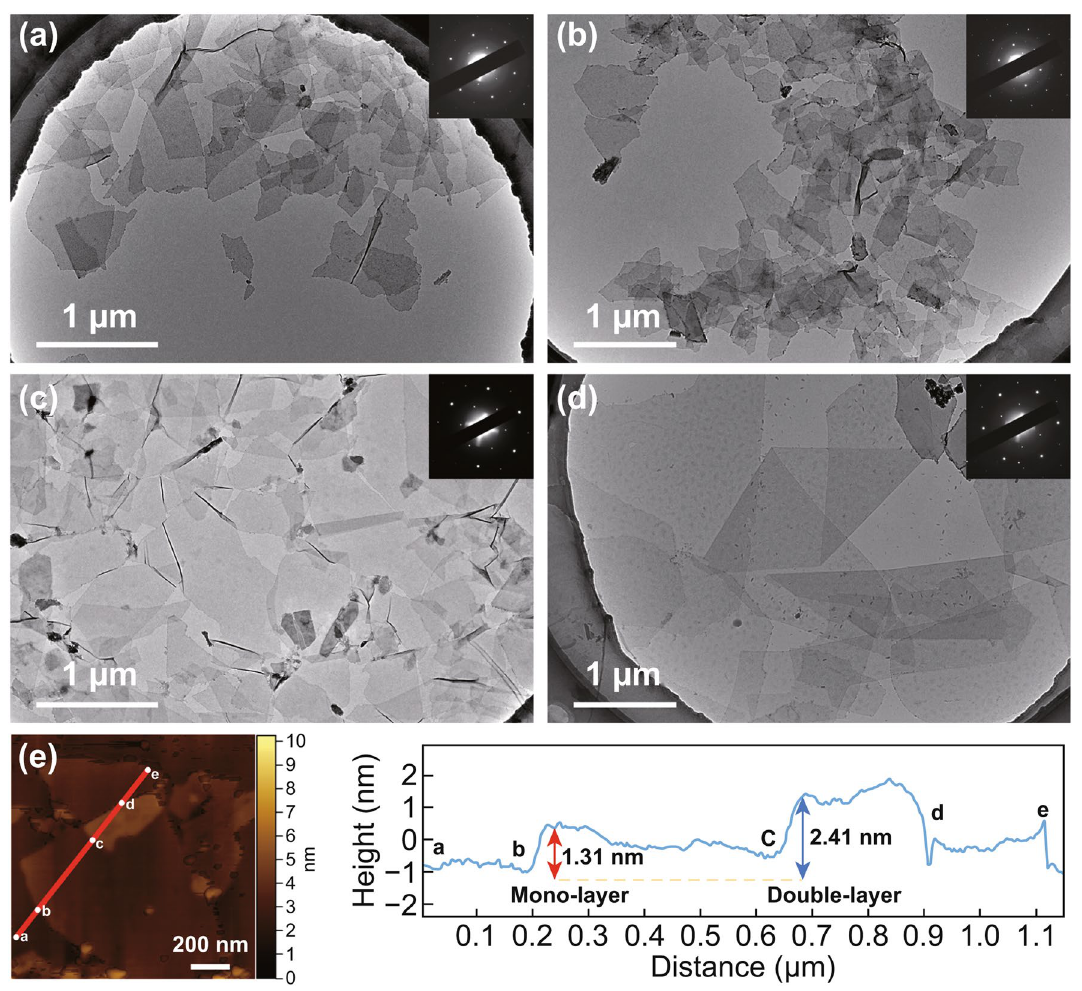
Fig. 2 TEM images of a S-Ti 3 C 2 T x -1, b S-Ti 3 C 2 T x -6 flakes through Route II, c O-Ti 3 C 2 T x -1 and d O-Ti 3 C 2 T x -6 flakes through Route III. (Inset shows the SAED pattern). e AFM image of O-Ti 3 C 2 T x flakes with the height profile alongside the red